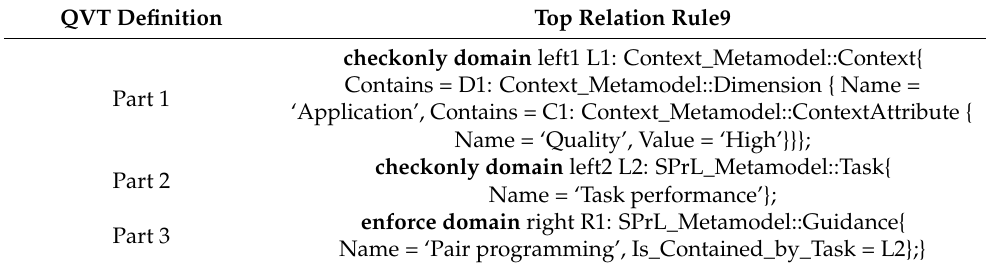
Table A3. An excerpt of the transformation implemented for resolving “Pair programming”.